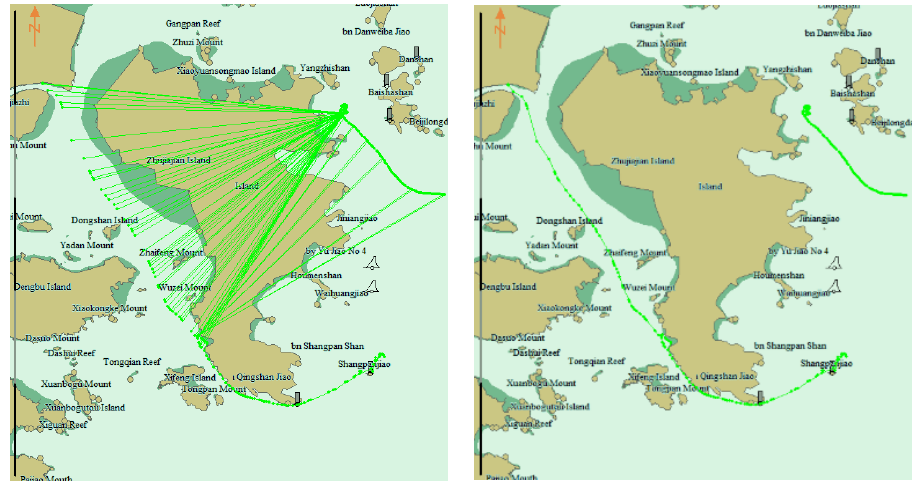
Figure 12. Clean result of two trajectories with the same MMSI. Left picture is the Uncleaned trajectories, the lines between the dots crossing land. Right picture is the cleaned trajectories, two trajectories are separated.